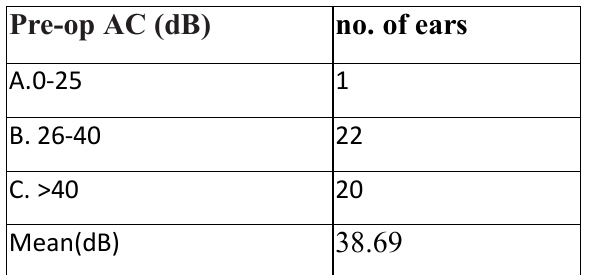
Table 4: Relative frequency of graft takes rate in relation to the site of perforations